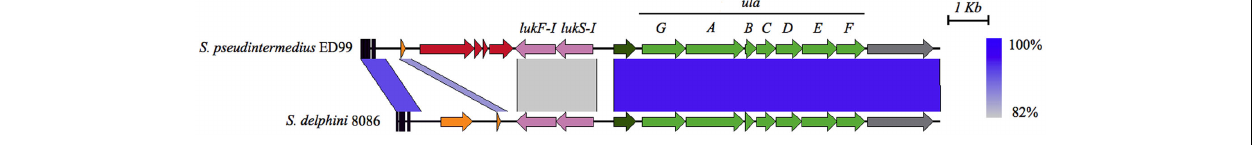
and function as follow: phage-related genes in red; leukotoxin genes in pink; putative phosphoglucomutase in dark green; L-ascorbate transport and utilization genes in green; putative transcriptional regulator in gray; tRNA genes are represented by black boxes; and genes encoding hypothetical proteins in